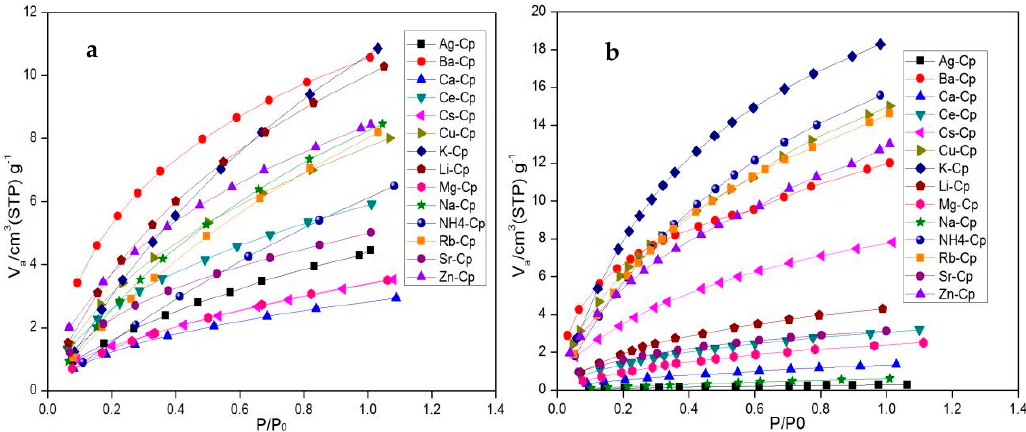
Figure 7. Low-pressure nitrogen ( a ) and methane ( b ) isotherms on modified Cp at 298 K. Table 2. The adsorption capacity of clinoptilolite for CH 4 and N 2 (at a pressure of approximately 1.01 × 10 5 Pa at 298 K).